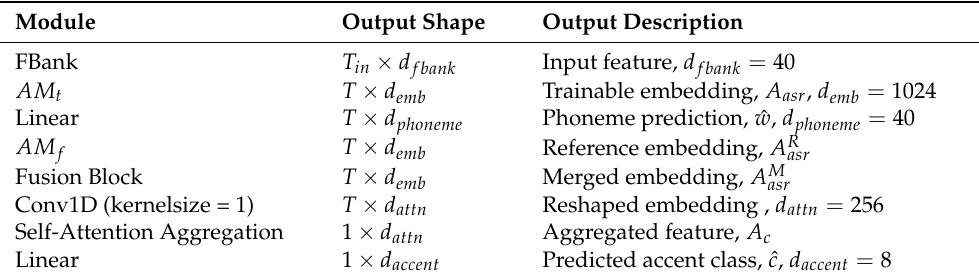
Table 1. Output summary of the proposed model. T in is the length of the input sequence. Please note that the acoustic model will downsample the feature sequence by 2 on the time domain, i.e., T in = 2 T